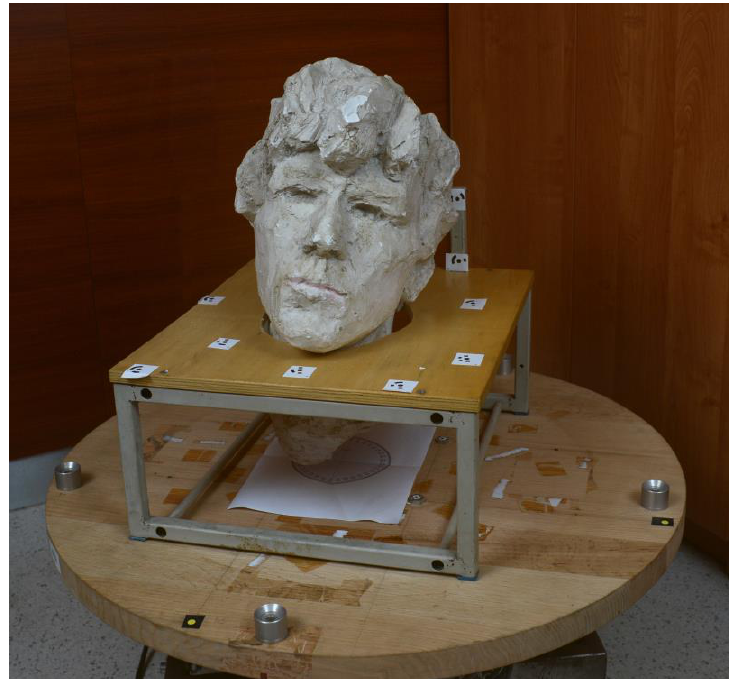
Figure 2. Sculpture used in the research. Ground control points are visible on the table underneath.